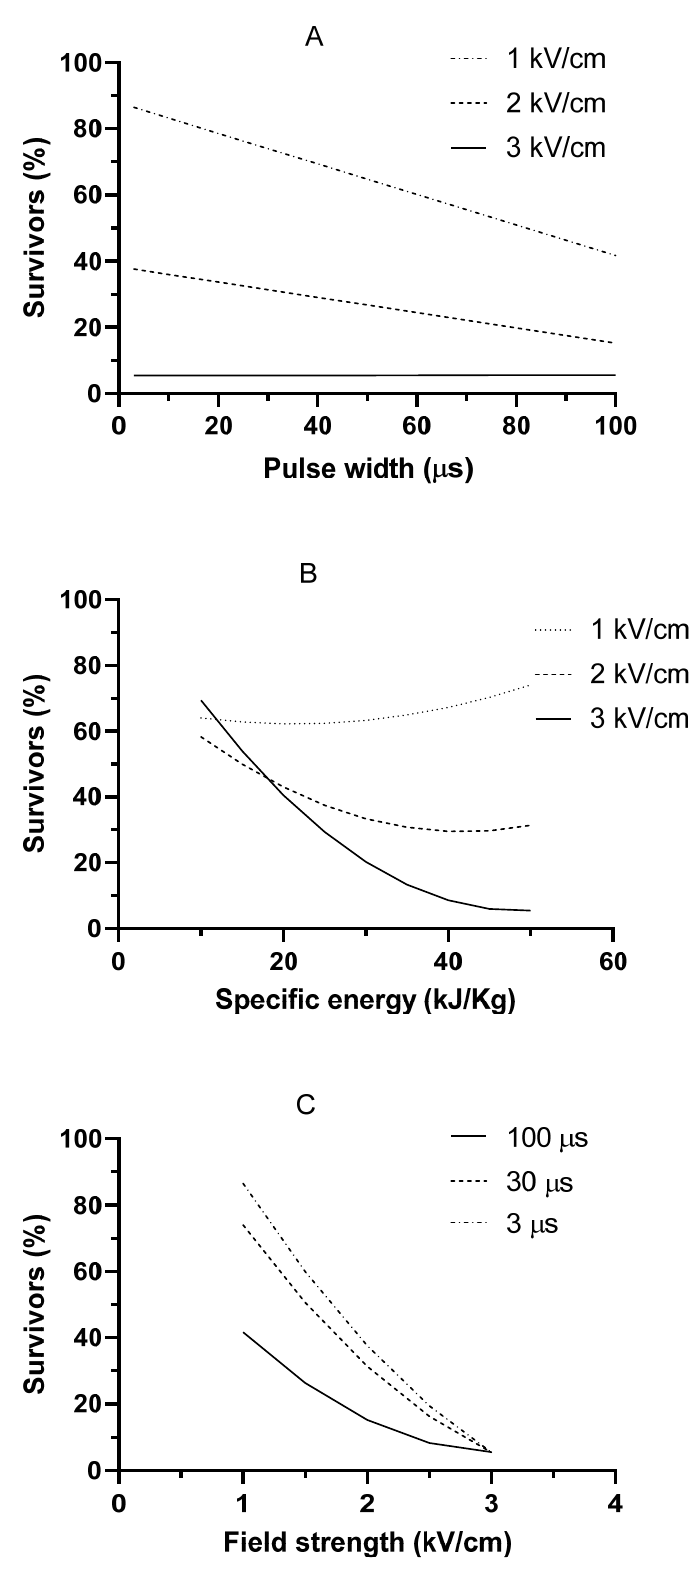
Figure 3. Influence of pulse width ( A ), specific energy ( B ), and field strength ( C ) on the estimated sur- vivability of Anisakis larvae L3 when applying pulses of 50 kJ/kg ( A , C ) and 30 µ s ( B ) in saline